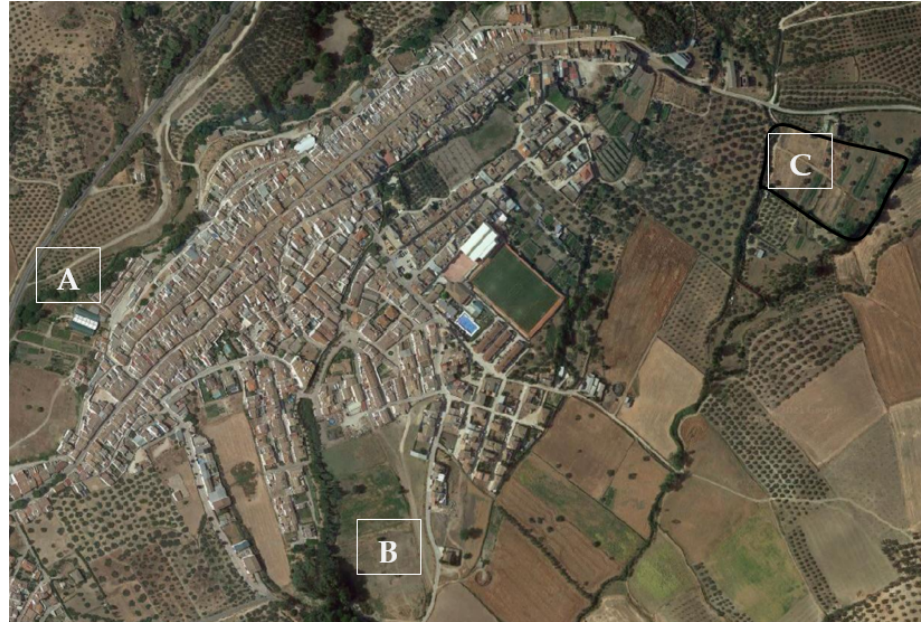
Figure 4. Aerial view of Extiercol project sites at Cuevas del Becerro (Málaga, Spain). ( A ) Greenhouse ( B ) Self Cosumption gardens ( C ) Current farmland.